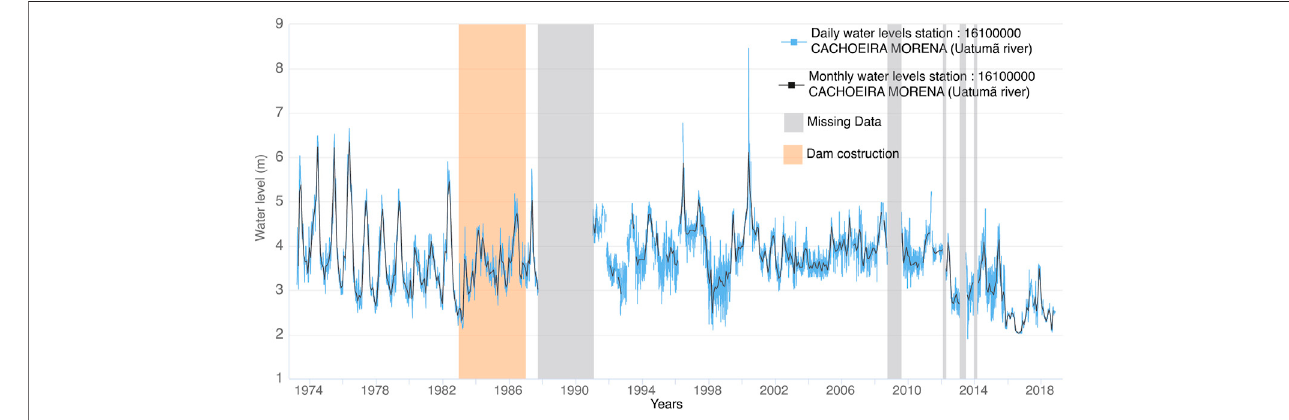
FIGURE 2 | Water levels in gauge station Cachoeira Morena.